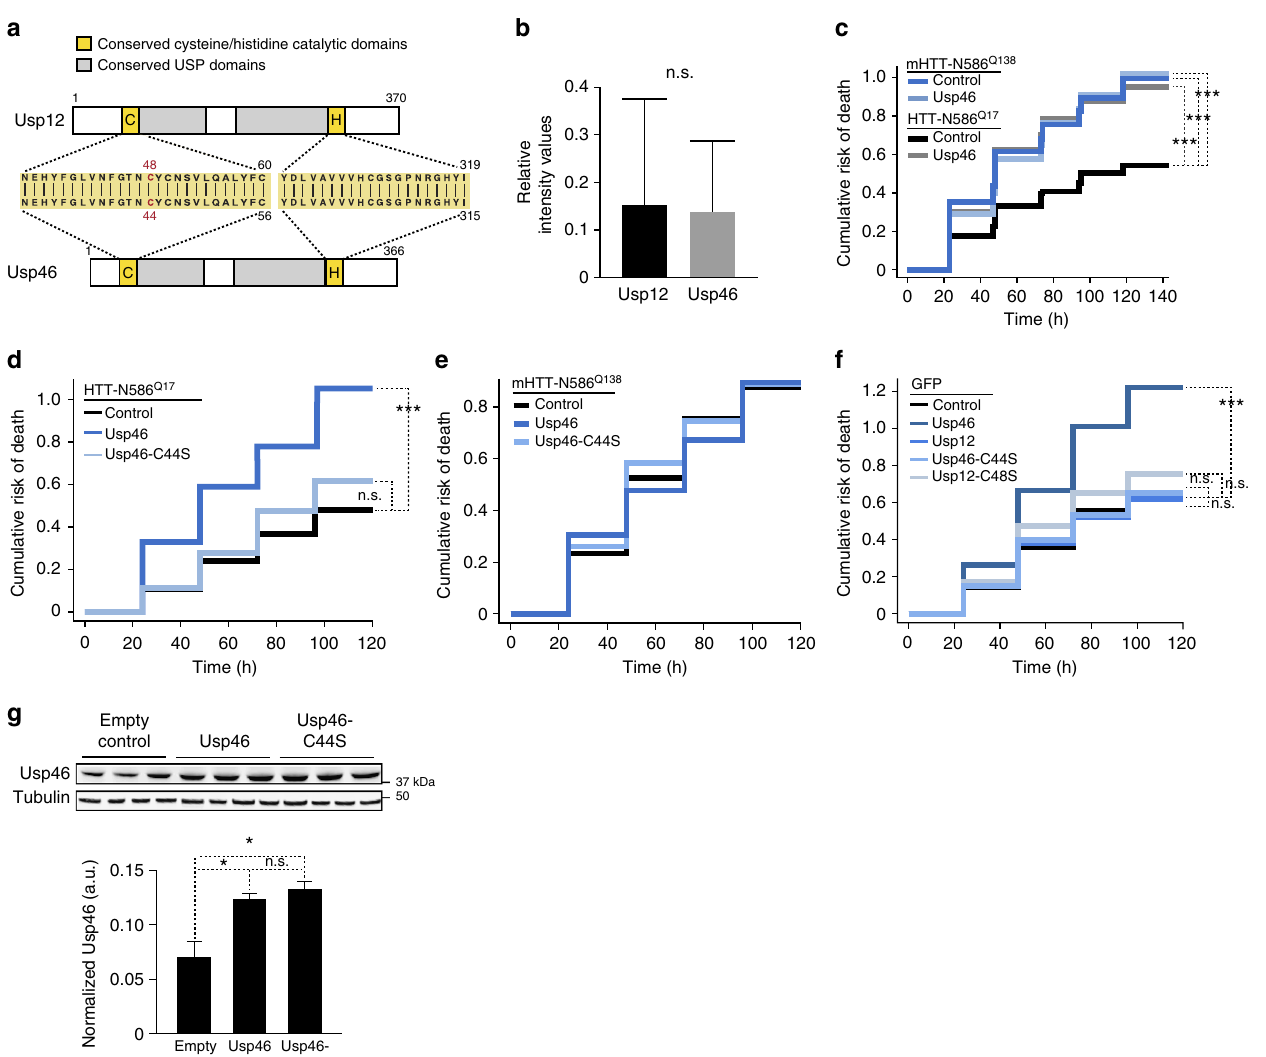
Fig. 3 Differential effects of Usp12 and Usp46 on mHTT toxicity and neuronal survival. a Schematic representation of Usp12 and Usp46 protein domain structure with sequence alignment of the conserved regions at the active-site cysteine and histidine domains (highlighted in yellow). b Relative intensity values of primary neurons transfected with GFP-Usp12 ( n = 47) and GFP-Usp46 ( n = 46) plasmids normalized to RFP control. Data are representative of three independent experiments and values are expressed as mean ± s.d. p Value ( p = 0.72) was determined with unpaired t test. c – e Cumulative hazard plots for primary neurons co-transfected with HTT-N568 Q17 or mHTT-N568 Q138 , and Usp46 or Usp46-C44S and controls. f Neuronal toxicity of Usp12 and Usp46 co-transfected with GFP control. Cox proportional hazards analysis was used to estimate the relative risk of death, or hazard ratio (HR), and the p value was determined with the log rank test (*** p < 0.001) (Supplementary Table 5). g Expression and stability of Usp46 and Usp46-C44S are equivalent in PC12 cells transfected with these plasmids. PC12 cells co-transfected with empty vector, Usp46, or Usp46-C44S expression constructs were lysed and subjected to SDS-PAGE and immunoblotting with Usp46 antibody. Tubulin was assayed as a loading control. One-way ANOVA, multiple comparison. Normalized Usp46 intensity of the empty vector vs. Usp46 ( p = 0.0457), empty vector vs. Usp46-C44S ( p = 0.0138), and Usp46 vs. Usp46-C44S ( p = 0.5855, s.e.m. are